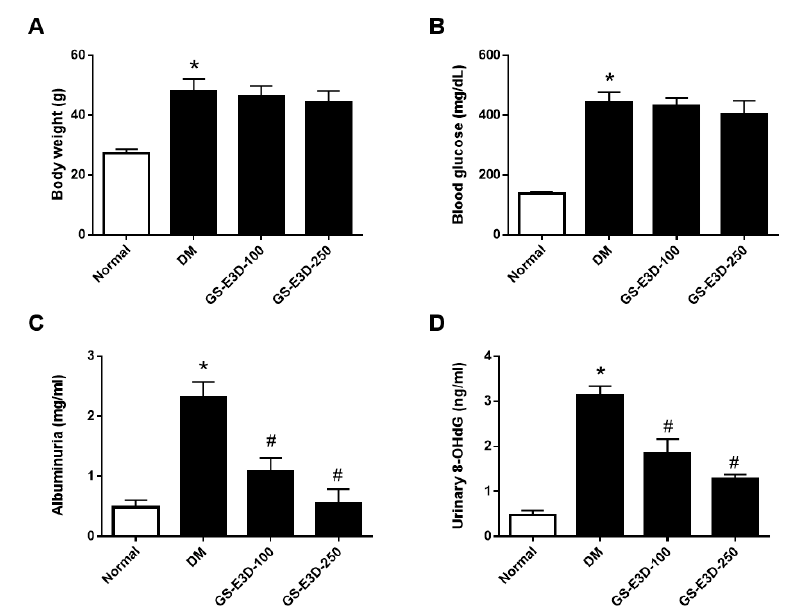
Figure 2. Effect of GS-E3D on physiological parameters in type 2 diabetic db/db mice. ( A ) Body weight. ( B ) Blood glucose levels. ( C ) Albuminuria. ( D ) Urinary 8-OhdG levels. Data are presented